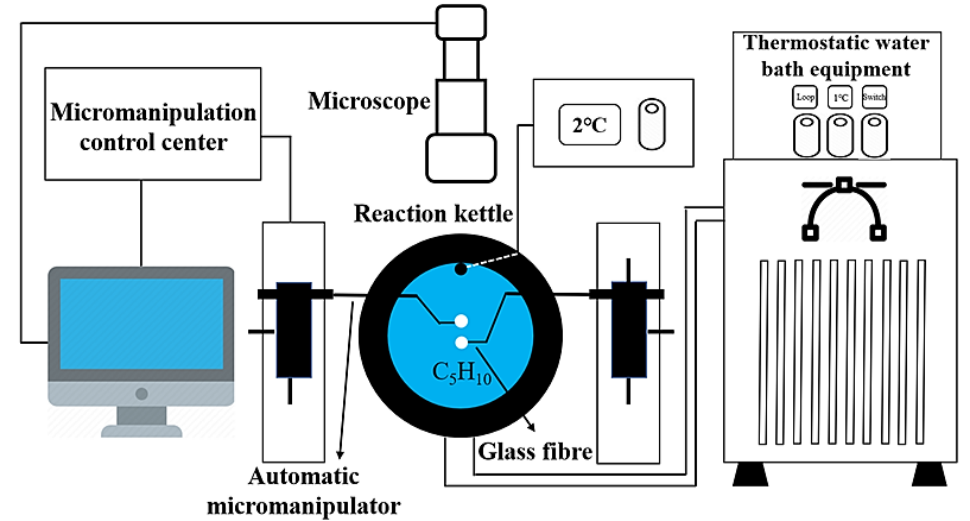
Figure 1. Apparatus used for measuring the cohesive force between hydrate